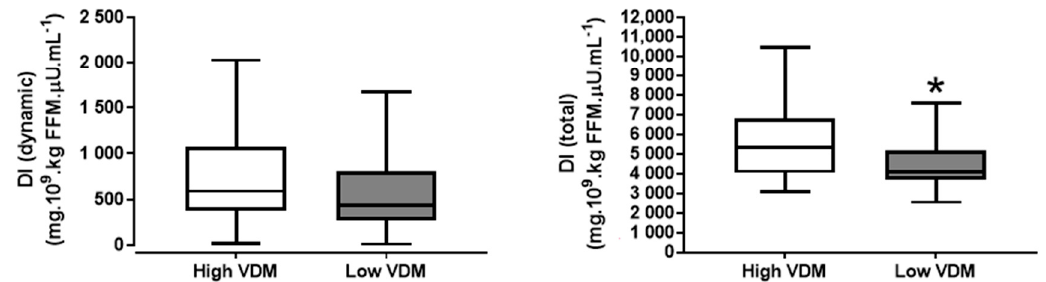
Figure 2. Peripheral insulin sensitivity ( a ) and the static, dynamic, and total ( b – d ) disposition index (DI) in the high and low VDM index subjects matched for age, sex, BMI, and vitamin D exposure (serum 25(OH)D 3 ). Values are the mean ± SD ( a ) or median and quartiles ( b – d ). * p < 0.05; ** p < 0.01, the value is significantly di ff erent from the corresponding value in the high VDM index group. Table 2. Characteristics of subjects with a low and a high VDM